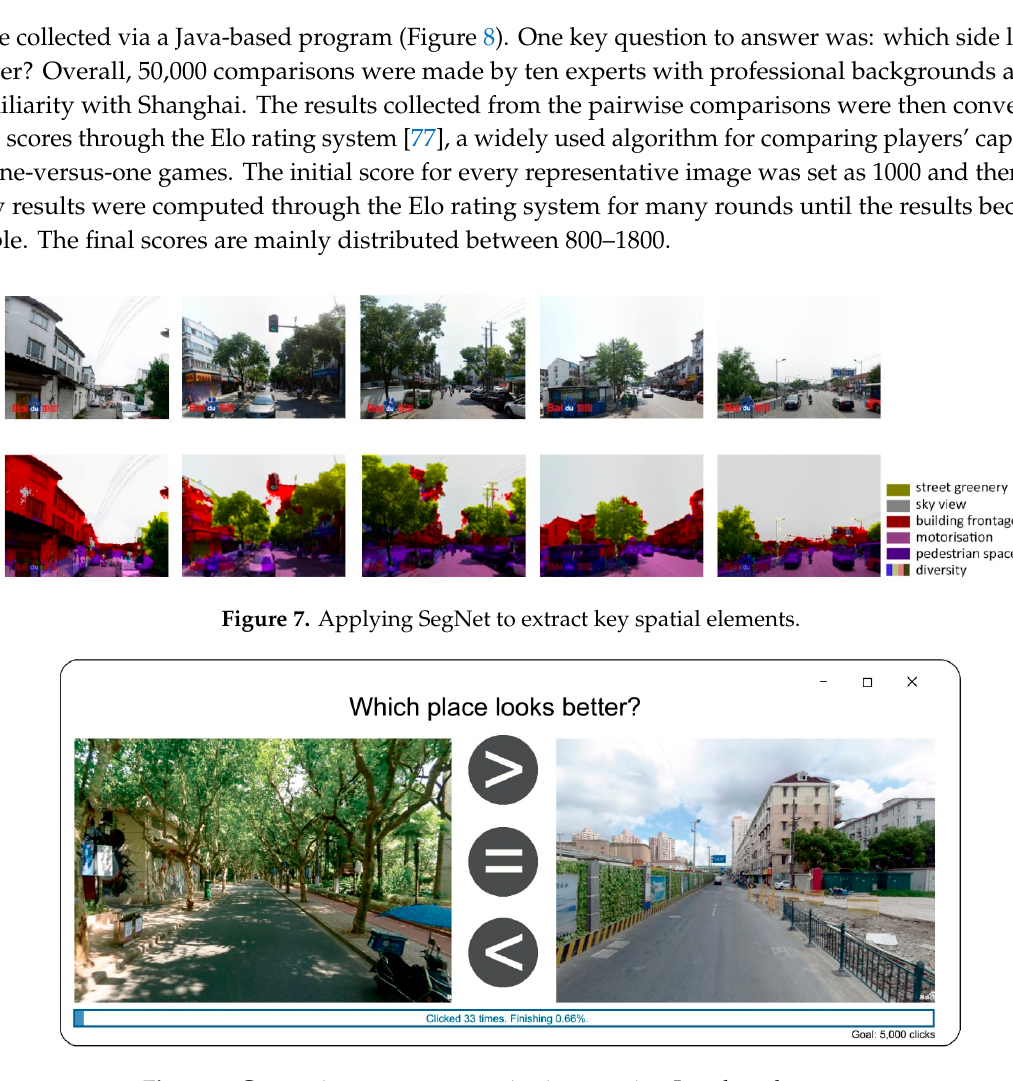
Figure 8. Comparison on representative images via a Java-based program.